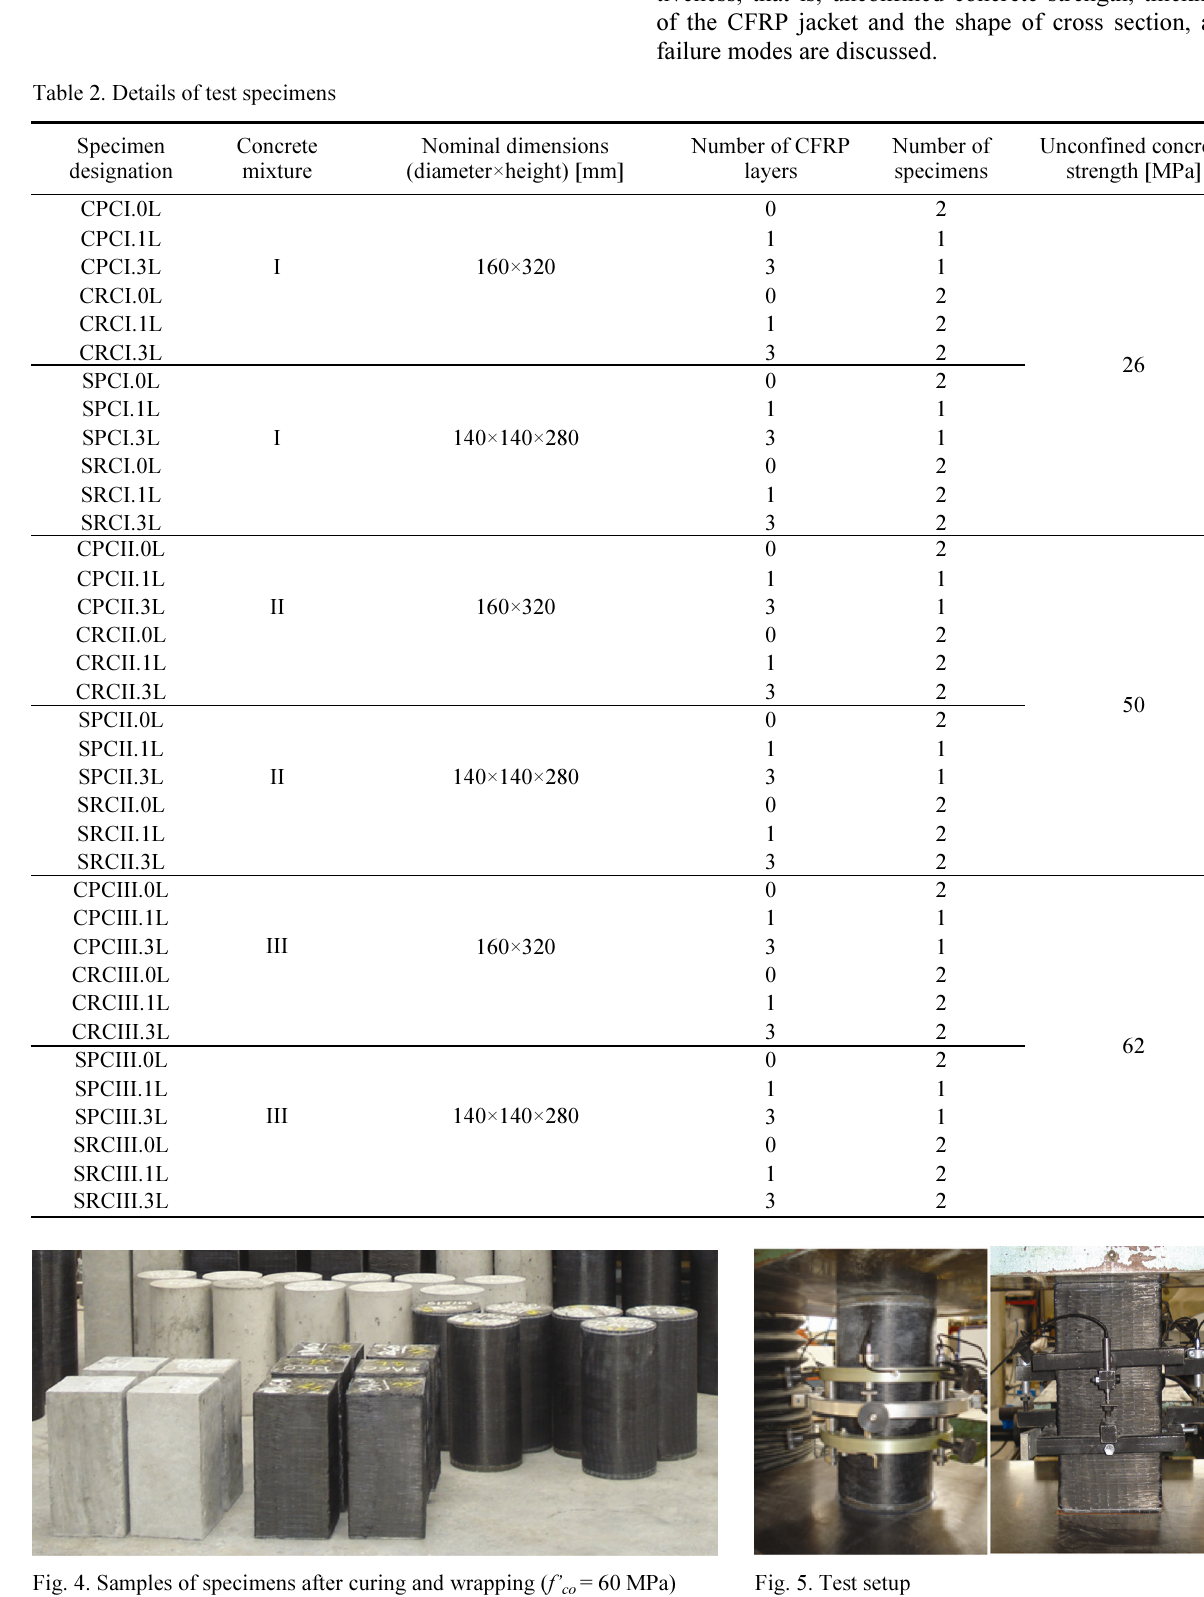
Fig. 4. Samples of specimens after curing and wrapping ( f’ co = 60 MPa) Fig. 5. Test